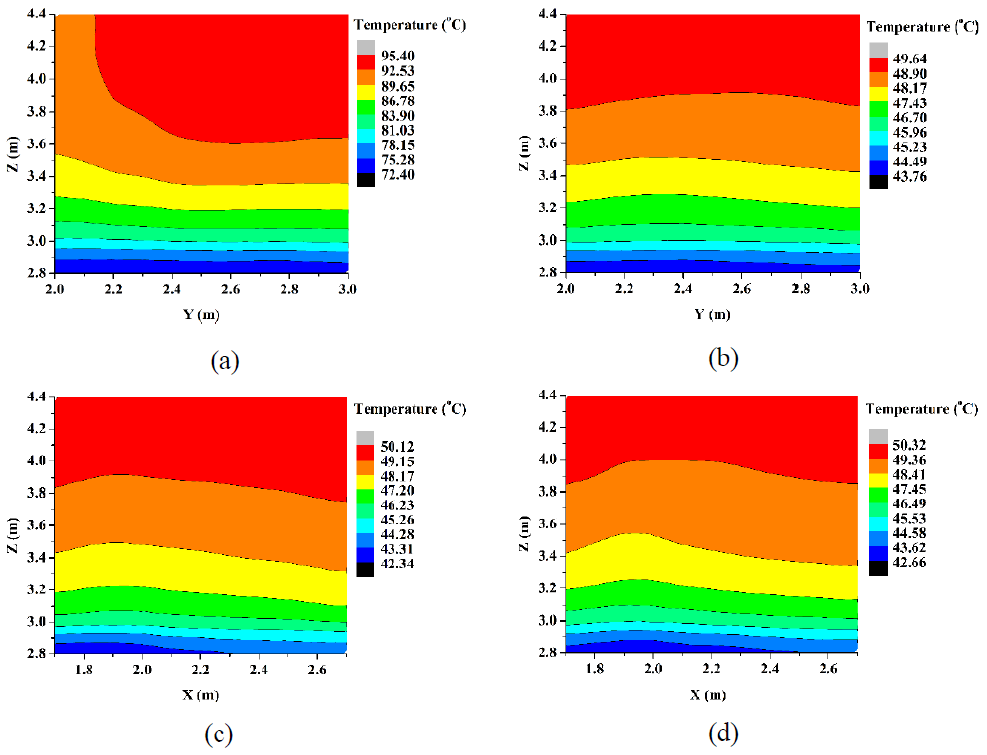
Figure 10. Temperature profile on ( a ) side A ( b ) side C ( c ) side B, and ( d ) side D of polyethylene shield 400 s after ignition of the